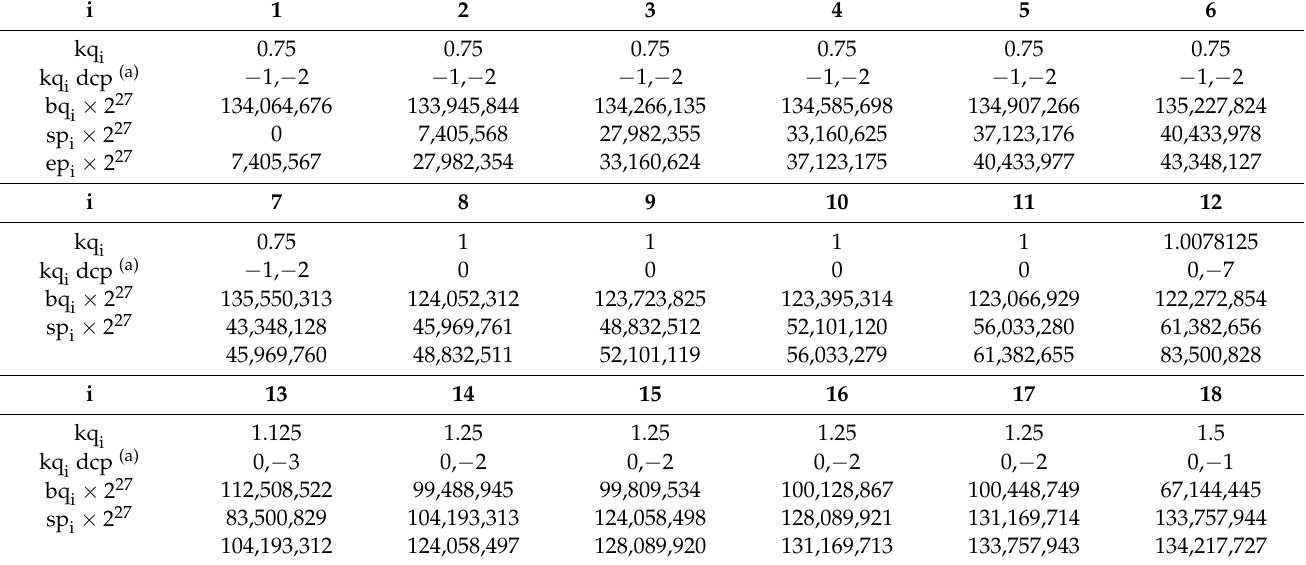
Table 4. The result of OML-PLAC for 2 x , x ∈ [ 0,1 ) .